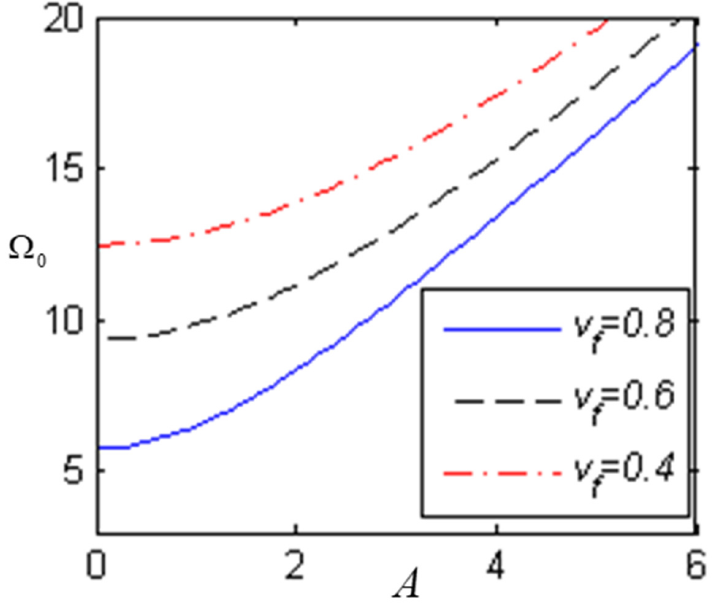
Figure 8. The variation in nonlinear frequencies with amplitudes for different flexural stiffness val- ues.